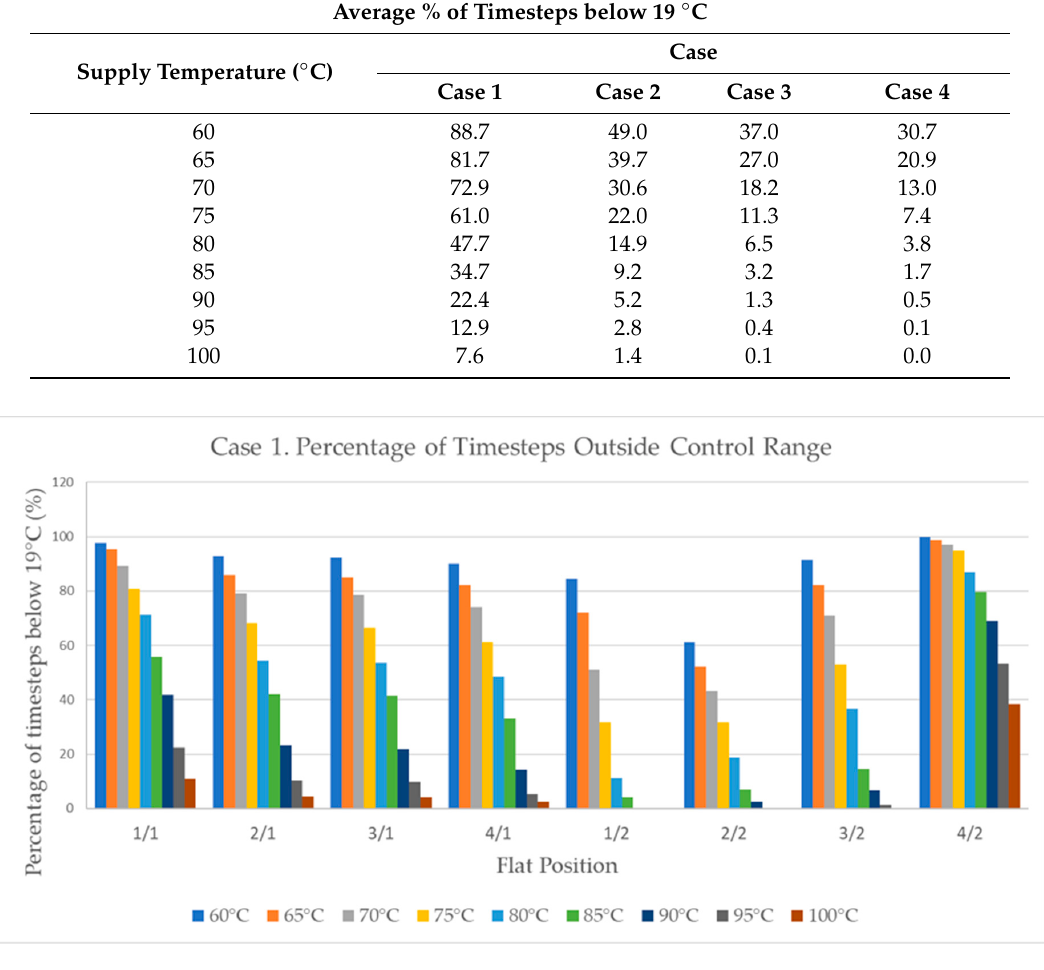
Figure 9. Case 1: no insulation and single glazing.